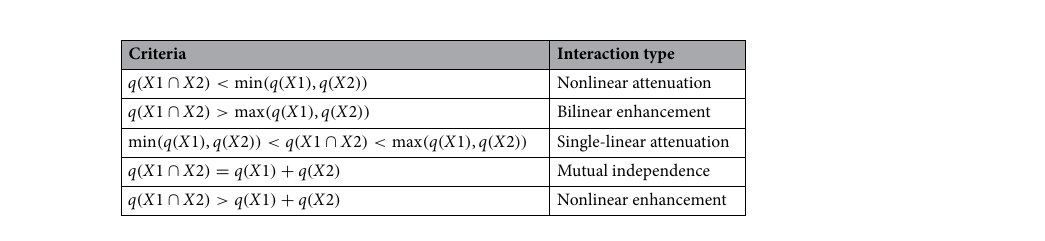
Figure 4. Fundamentals of factor detection.